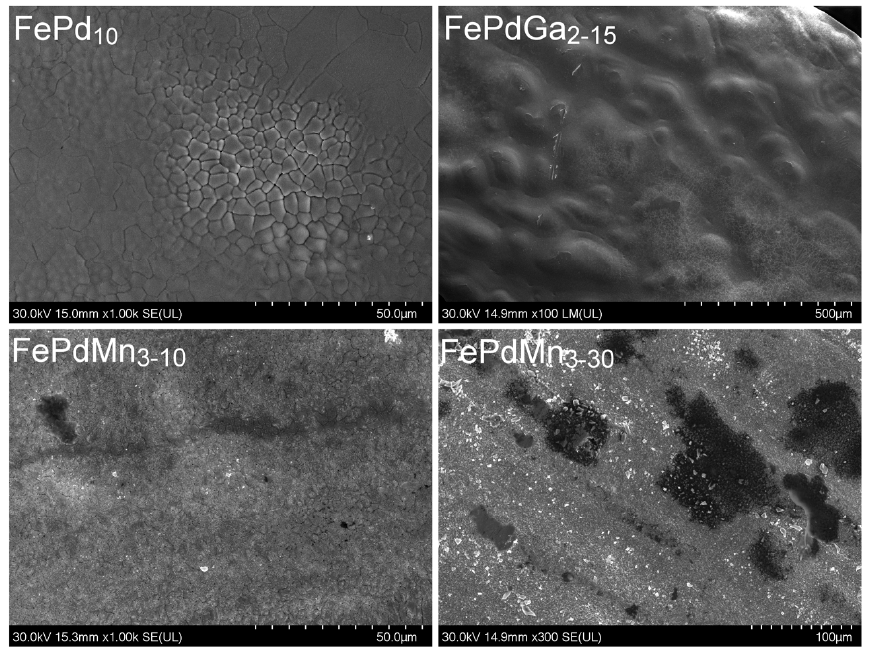
Figure 1. SEM results for as synthesized FSMA.